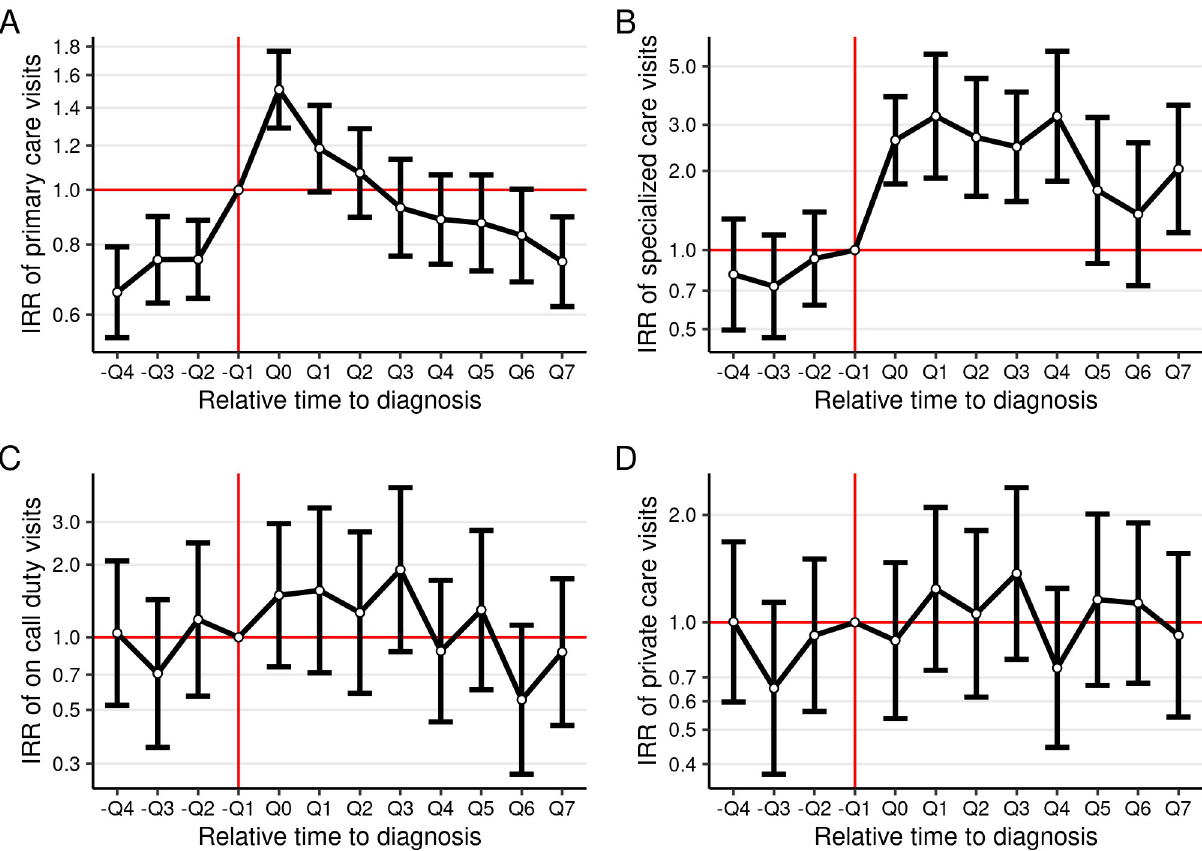
Fig 2. Event study regressions for number of visits. Y-axis shows the incidence rate ratio for the respective service. Y-axis is log-scaled. − Q 1 is the omitted event dummy and coefficients are thus normalized with respect to this event-period. Controls used in the regressions include fixed effects for the common time trend, age, and